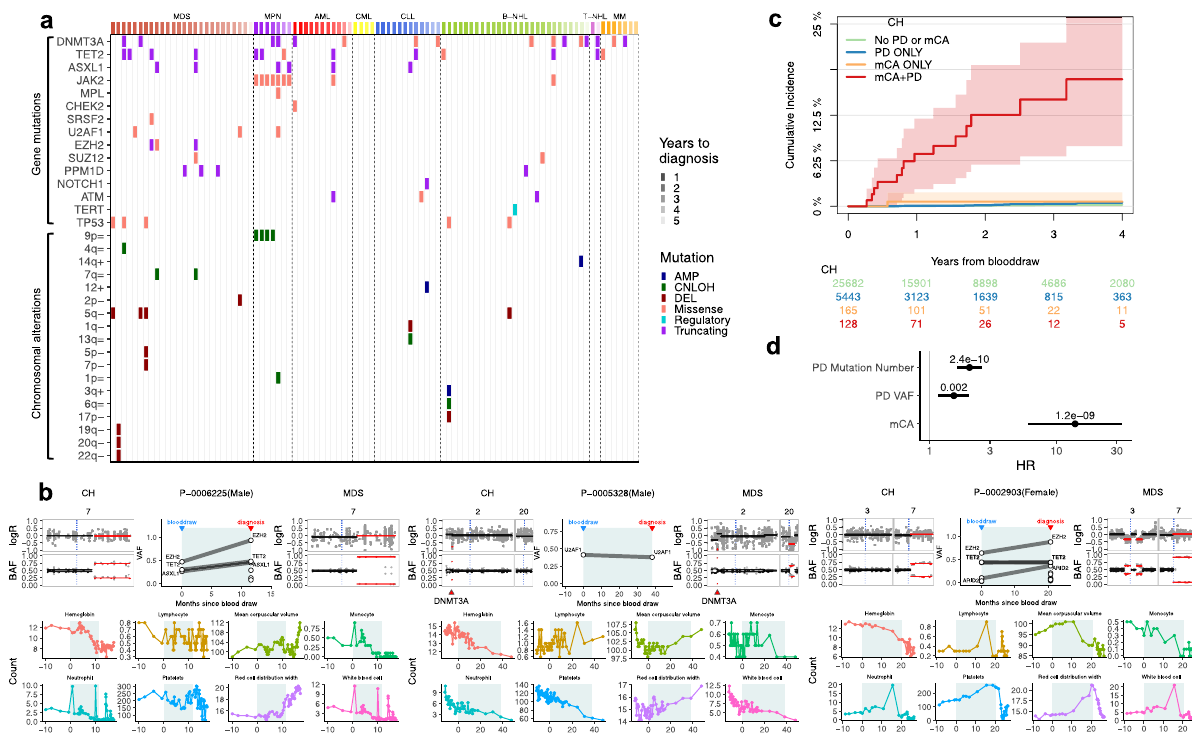
Fig. 4 mCA and evolution to hematologic malignancies. a CH mutations detected at initial blood draw in patients who had a subsequent hematological cancer diagnosis. Patients in each disease category (top bar) were arranged by increasing time to diagnosis. Events are colored by mutation types ( = , CNLOH; − , deletion; + , ampli fi cation). b Exemplar cases of genomic evolution from CH with detectable mCA to myeloid neoplasms. Gene mutations at the time points of blood draw and diagnosis are shown in the middle, while regions of chromosomal alterations are shown on the left and right, respectively. Solid lines indicate signal median. Aberrant regions are colored in red. BAF, B-allele frequency. Serial blood count indices are shown below, where the shaded areas in blue indicate the period between initial blood collection and MN diagnosis. c Cumulative incidence of leukemia among patients who had detectable mCA only, gene mutation putative driver (PD) only, both, or neither; 95% CIs are shown in shaded ribbons. d Association of CH features with subsequent leukemia diagnosis. Hazard ratios (HR; solid dots), 95% CIs (horizontal bars), and unadjusted P values (above horizontal bars) are derived from a multivariable cause-speci fi c Cox regression model with a 9 month landmark. The HR for 10% increment in gene mutation PD VAF was shown. mCA status was included as a binary indicator. Source data are provided as a Source Data fi